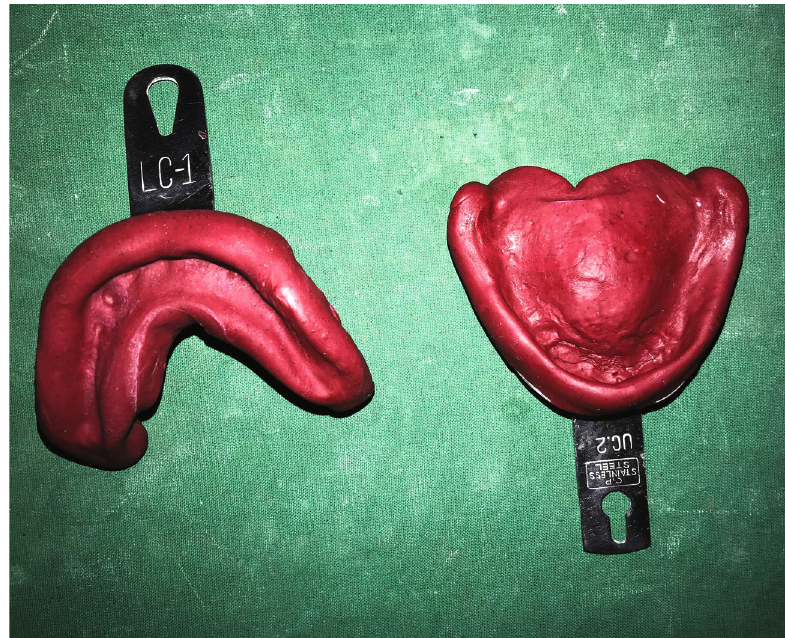
Figure 1: Primary impression.